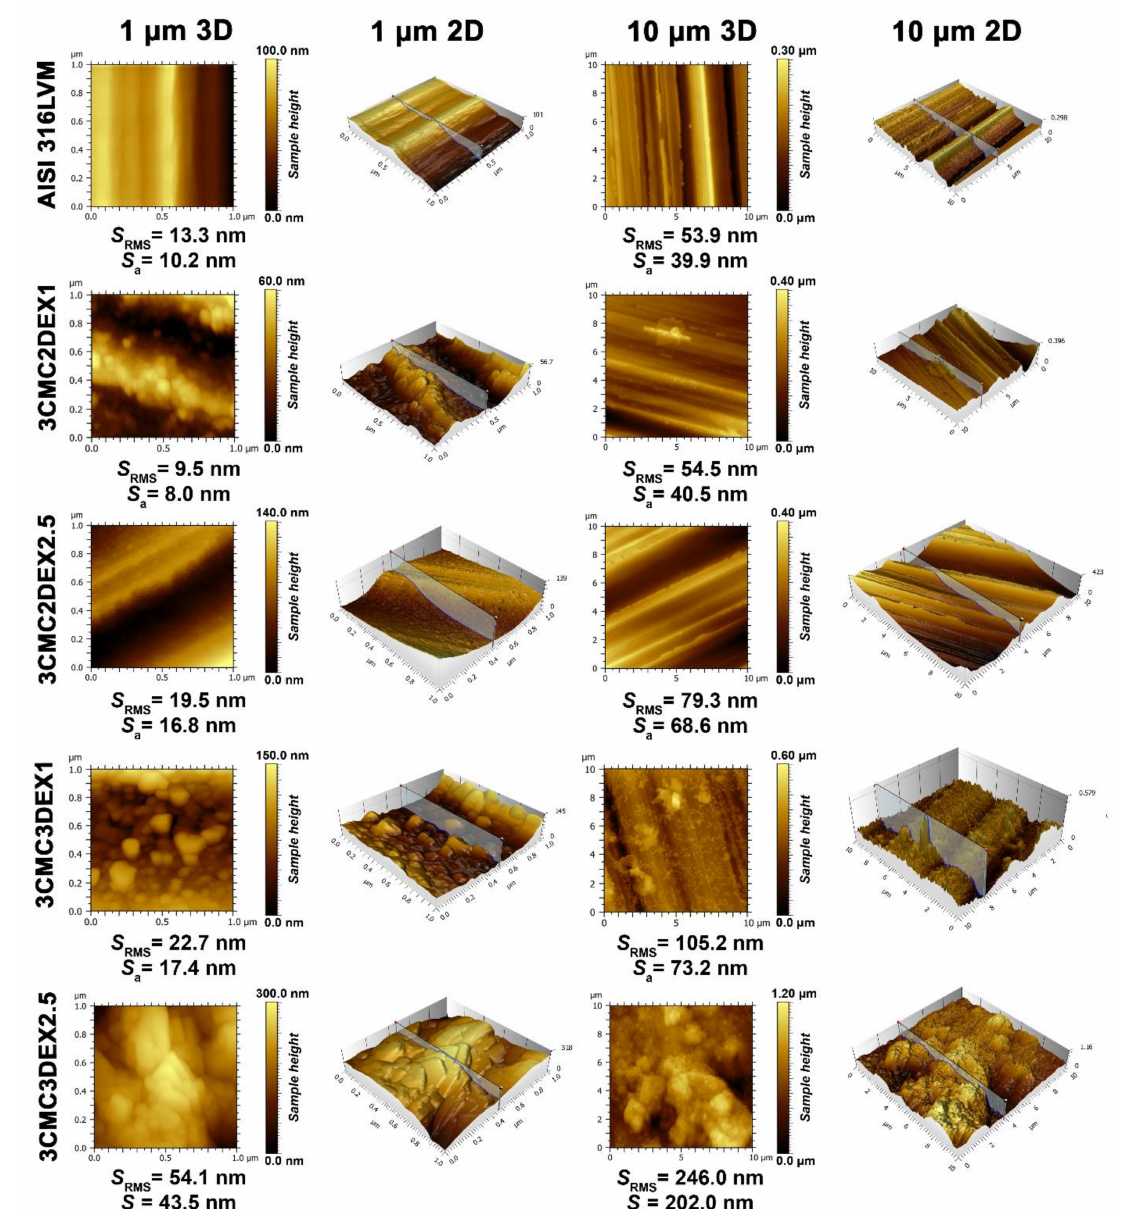
Figure 3. AFM topography measurements for all samples and AISI 316LVM in 2D and 3D, accompanied by the correspond- ing roughness